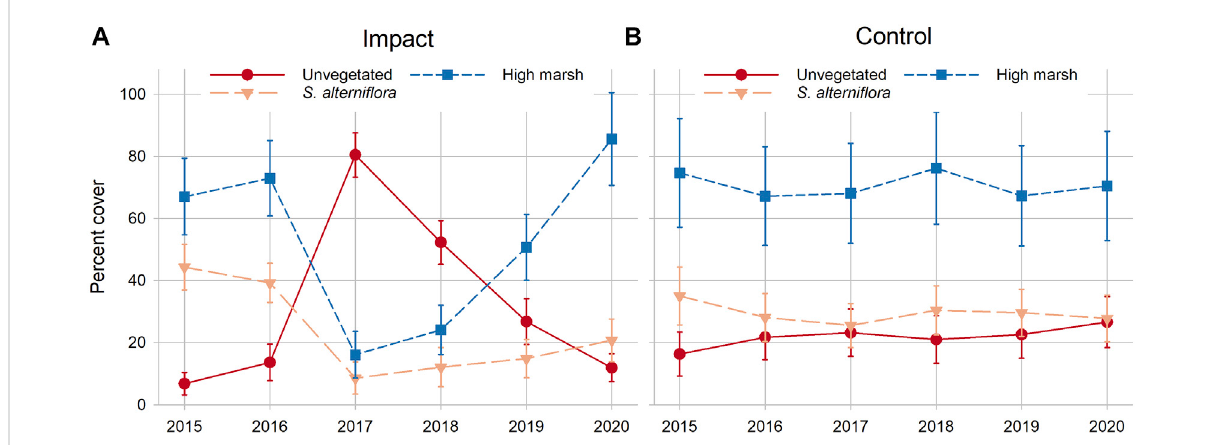
FIGURE 7 Changes in percent cover of unvegetated ground, Spartina alterni fl ora and high marsh grasses (Spartina patens, Juncus gerardii and Distichlis spicata combined) over time in the impact (A) and control (B) marshes. Sediment placement occurred during the winter between the 2016 and 2017 sampling periods. Error bars are 1